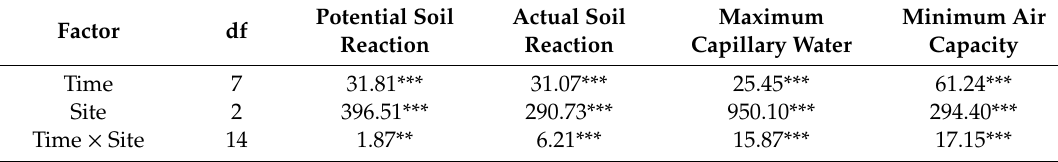
Table 1. Main e ff ects due to sampling time, sampling site, and their interaction on the variability of selected chemical variables. Values are F-values (F-stat) from two-way ANOVA (Time × Site) with